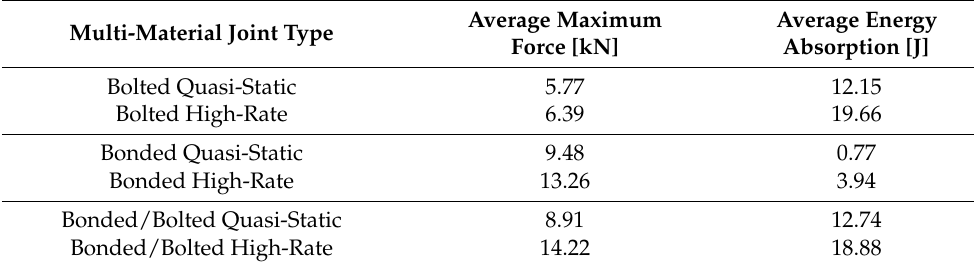
Table 5. Average maximum force and energy absorption for each joint type and loading